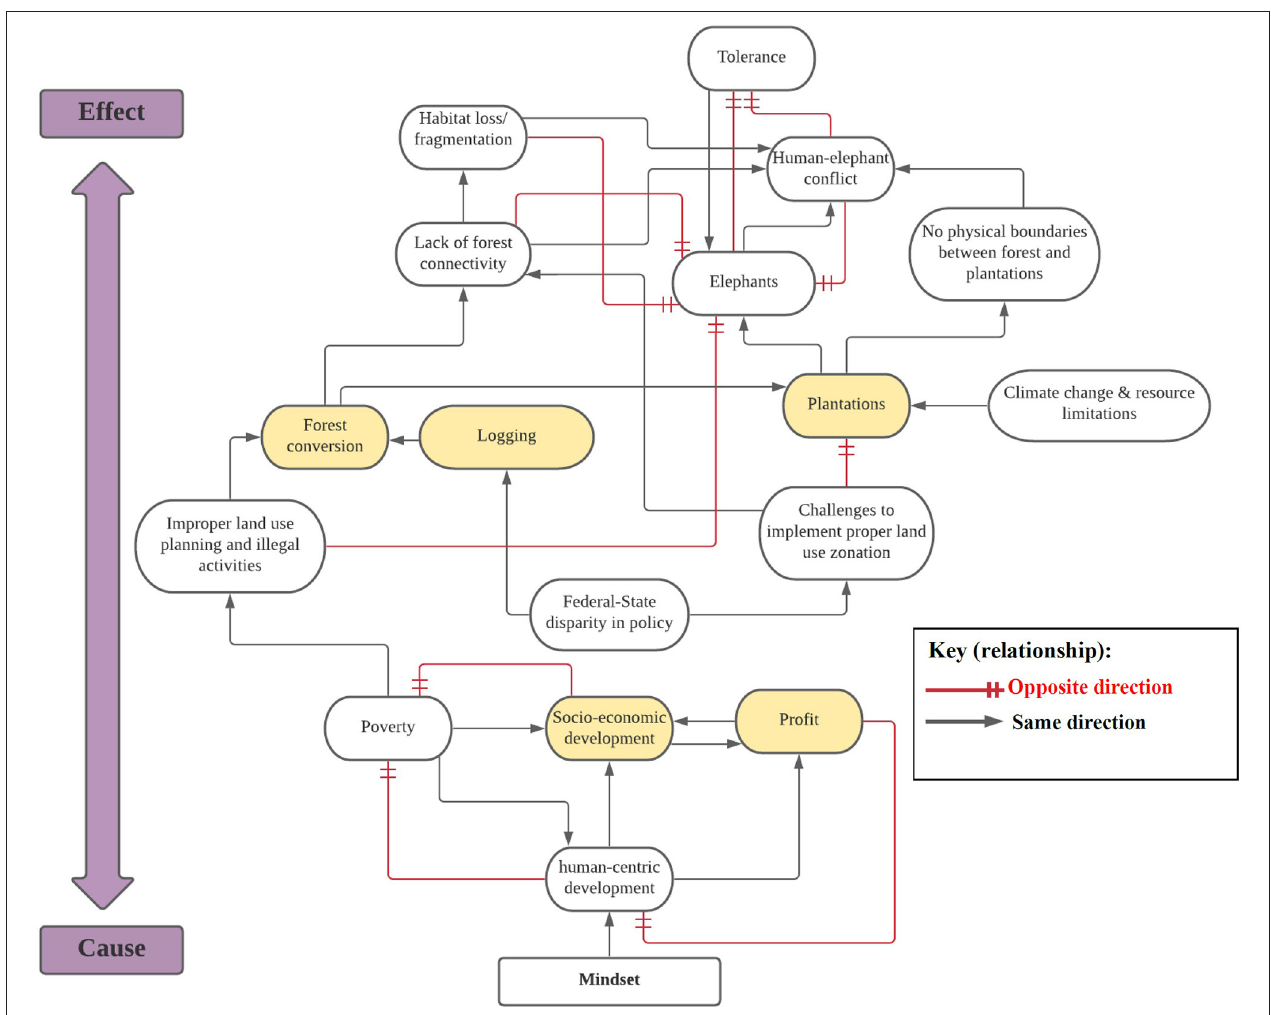
FIGURE 1 | The problem tree identifying challenges for wild elephant conservation arranged on a cause-and-effect continuum, with relationships between issues depicted using systems thinking approach. Note that priority was given to highlight relationships directly impacting wild elephants. Although there are synergies and interactions for certain issues (highlighted in beige), but the relationships between these issues are complex and are not depicted fully. © 2021 by Dr. Wong Ee Phin is licensed under Attribution-Non-Commercial 4.0 International. To view a copy of this license, visit